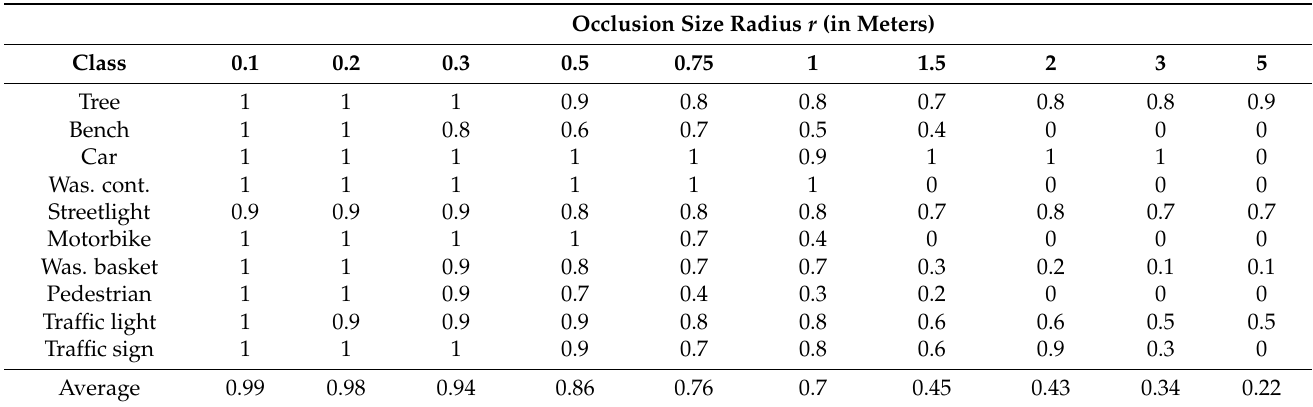
Table 10. Recall of classification with different occlusion